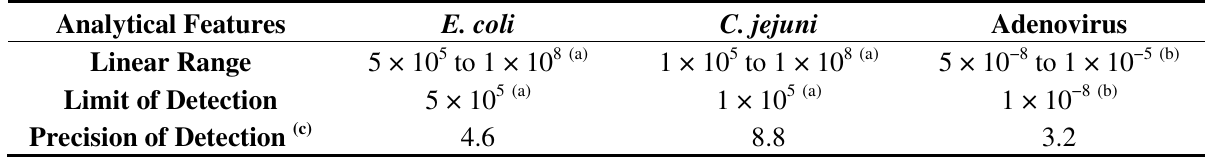
Table 1. Analytical performance for detection of three pathogens in single